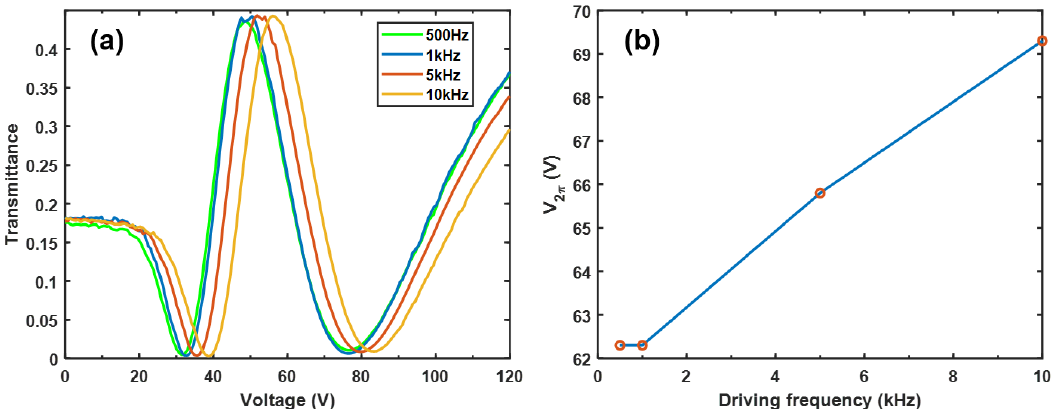
Figure 8. Measured ( a ) VT curves and ( b ) 𝑉 2𝜋 of PNLC-4 at different driving frequencies.